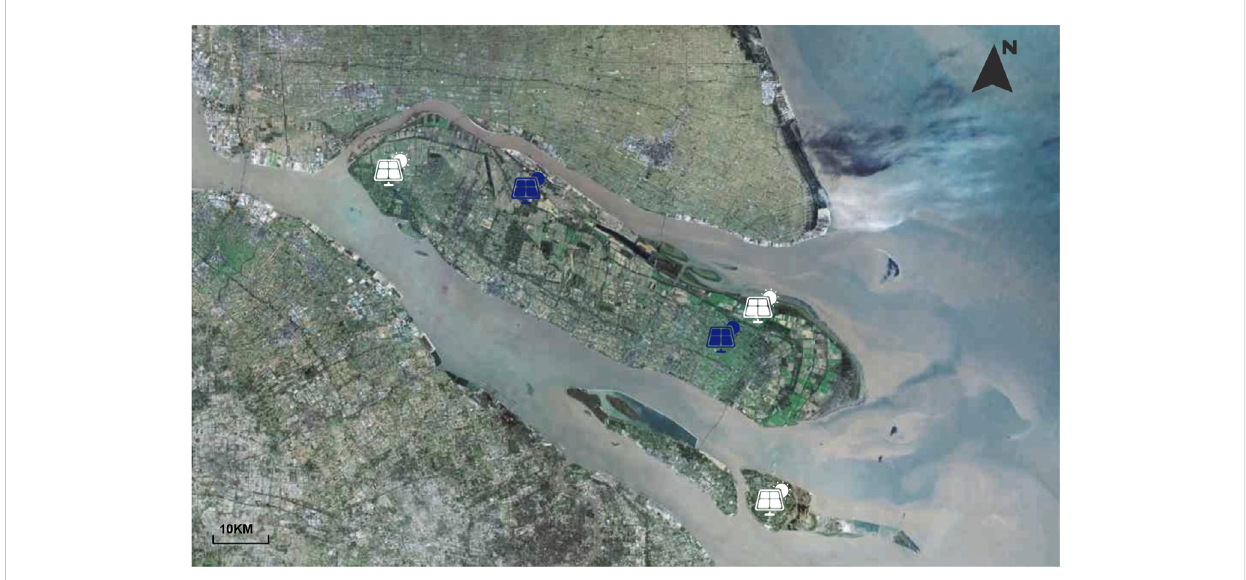
FIGURE 1 Chongming and its main photovoltaic projects. Note: Among the fi ve photovoltaic projects, the three completed projects are in Chenjia Town (110 MW), Lvhua Town (44 MW) and Hengsha Township (3.5 MW), respectively, and the two projects under construction are in Gangxi Town (128 MW) and Zhongxing Town (100